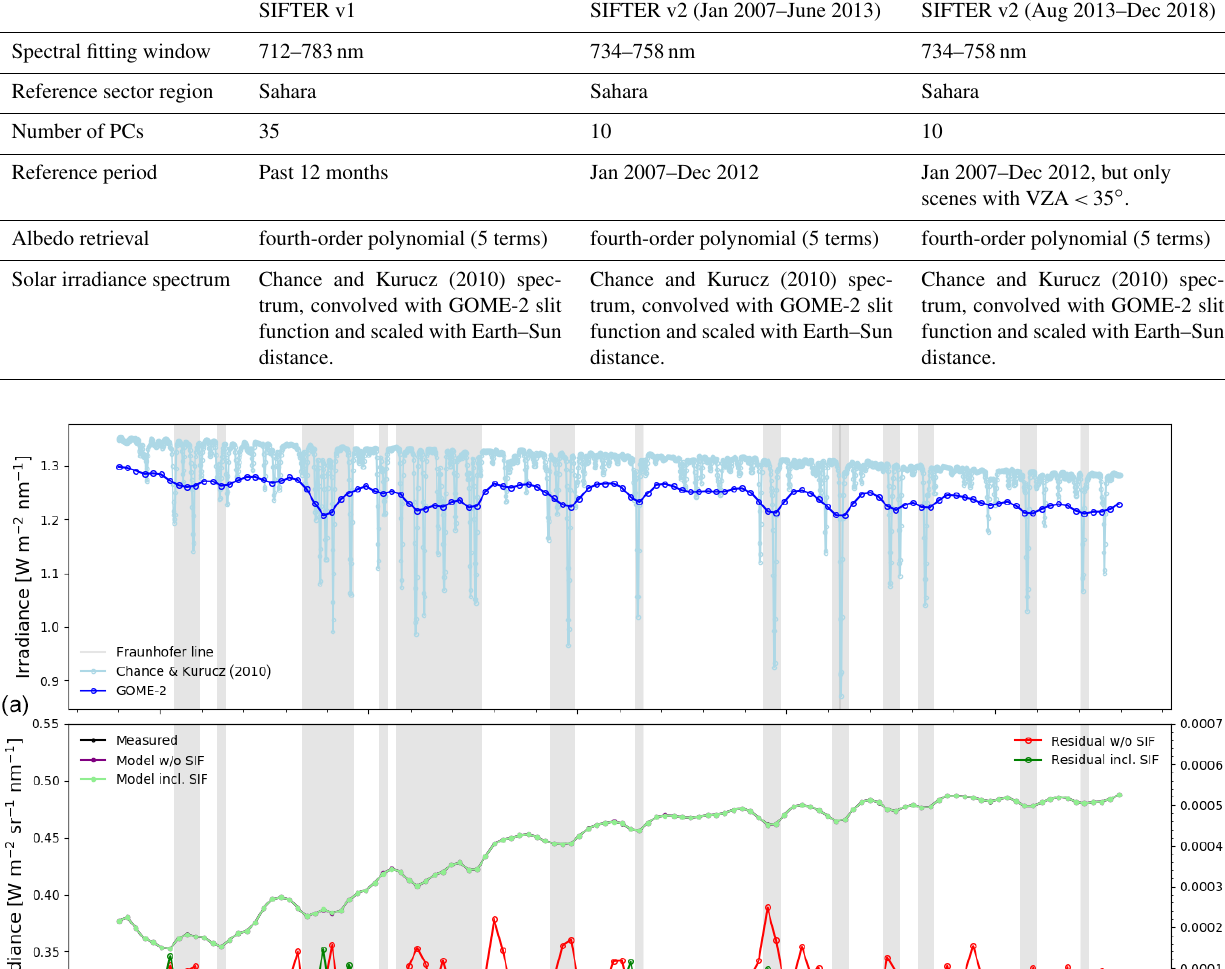
Table 4. Summary of individual changes in fluorescence retrievals from SIFTER v1 (Sanders et al., 2016) to SIFTER v2 (this work).